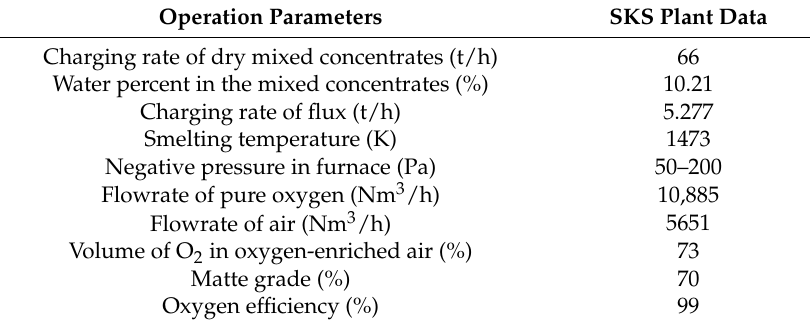
Table 6. Industrial operation parameters in SKS process.